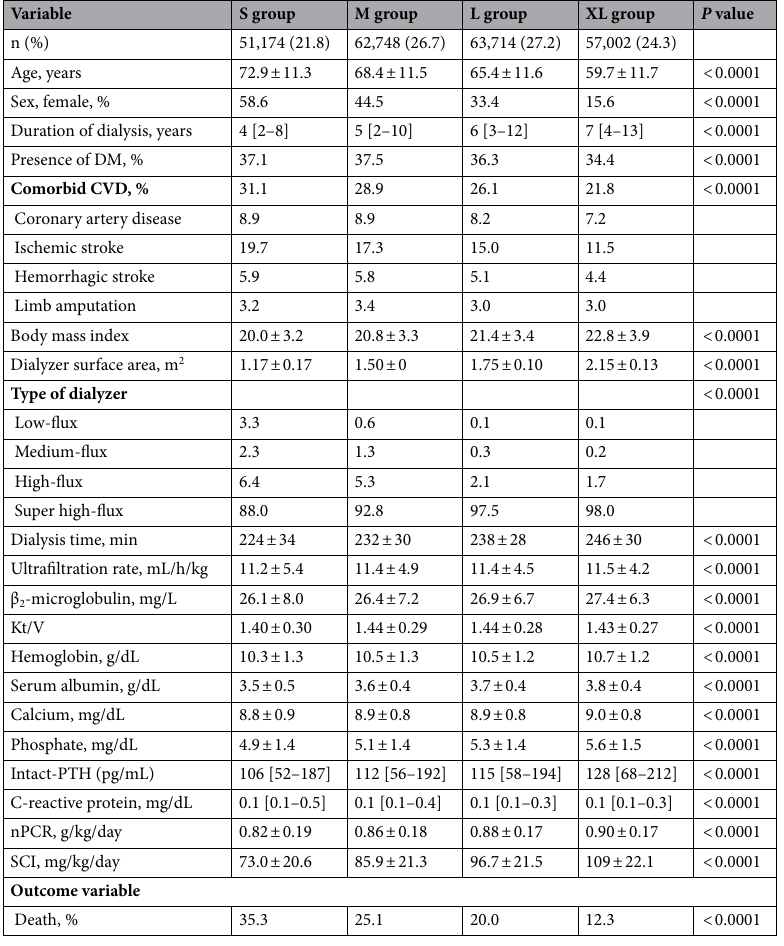
Table 2. Demographic, clinical, and laboratory data for 234,638 patients on hemodialysis according to dialyzer surface area. Data are expressed as mean ± standard deviation (SD), number (%), or median [interquartile range]. S group, small dialyzer surface area, < 1.5 m 2 ; M group, medium dialyzer surface area, 1.5 m 2 ; L group, large dialyzer surface area, 1.6 to < 2.0 m 2 ; XL group, extra-large dialyzer surface area, ≥ 2.0 m 2 . CVD cardiovascular disease, DM diabetes mellitus, nPCR normalized protein catabolic rate, PTH parathyroid hormone, SCI simplified creatinine